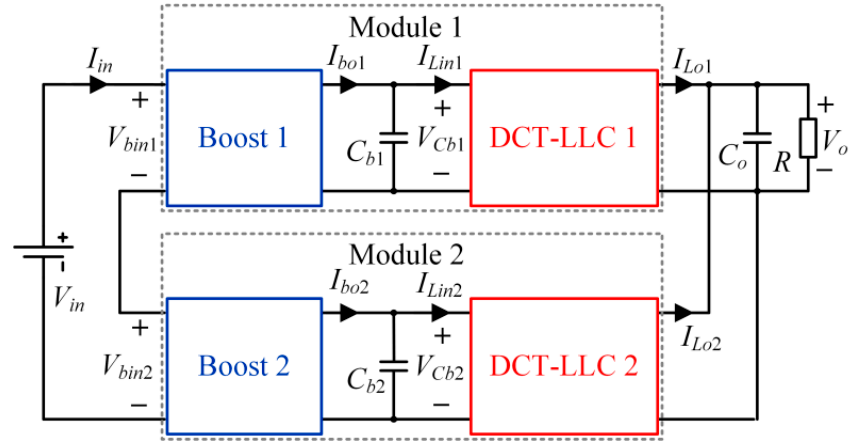
Figure 1. Topology of the ISOP system composed of Boost + LLC cascaded modules.